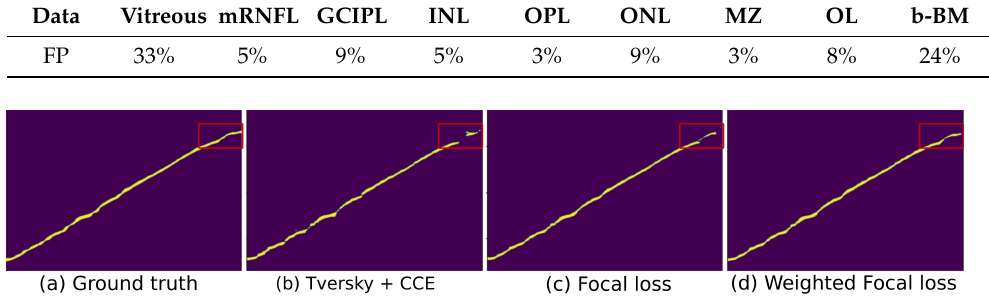
Figure 4. The comparison of different loss functions on a single class (INL). As can be seen, the weighted focal loss is capable of producing the minimum false